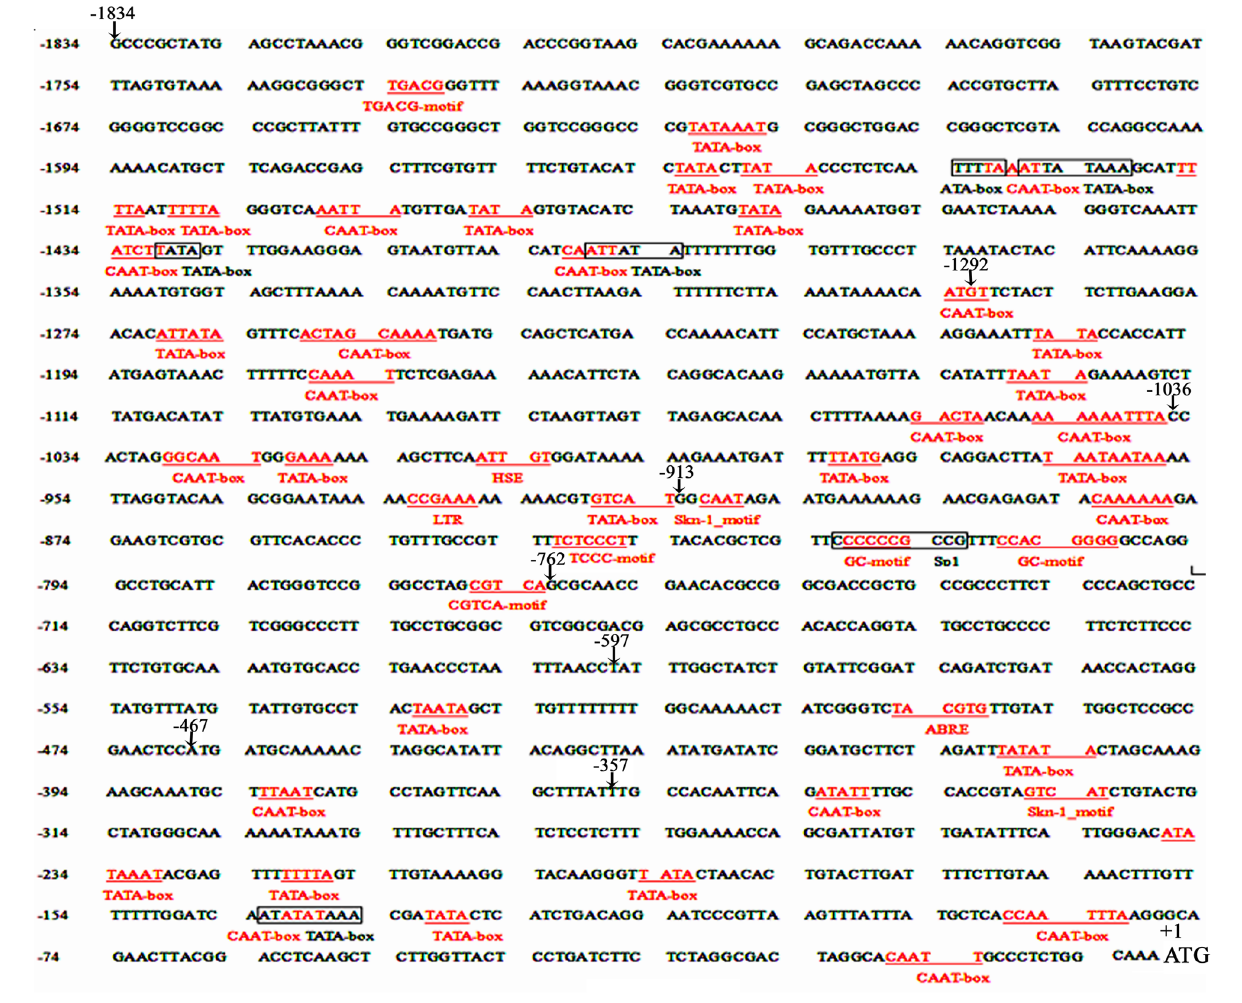
FIGURE 1 | Nucleotide sequence of the pZmPIS . The A of translation initiation site (ATG) of ZmPIS is numbered as + 1. Known cis -acting elements are shown in underline or border. The descriptions of elements see Table 2 . An arrow above the sequence indicates the start point of different deletion